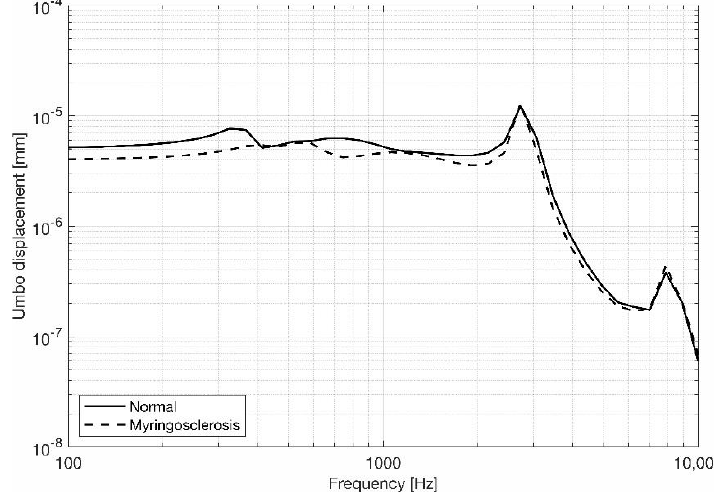
Figure 4. Umbo displacements’ magnitude, comparing the model that was representative of a normal ear and myringosclerosis.